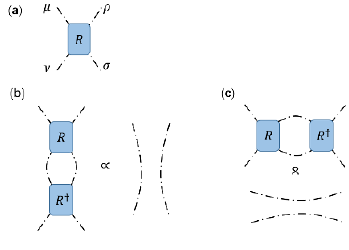
Figure 36 . (a) Tensor Q , where two indexes on each side are grouped together. (b) Tensor Q is proportional to the isometry between the two grouped indexes.